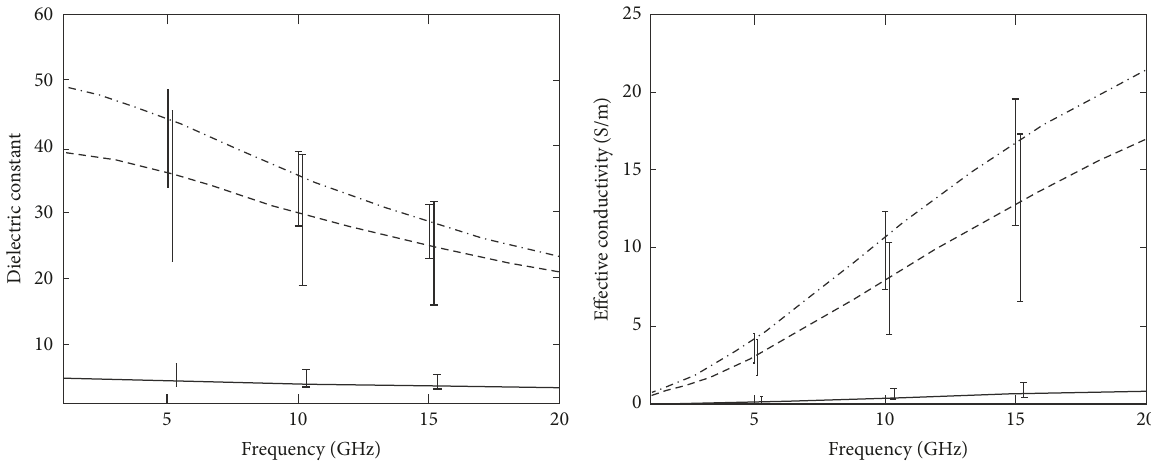
Figure 4: Median dielectric properties of normal breast tissue in three groups categorized by the amount of adipose, from the research team of Wisconsin University and Calgary University. Dash-dot line: group 1 (0–30% adipose), dashed line: group 2 (31–84% adipose), and solid line: group 3 (85–100% adipose) [10]. © Institute of Physics and Engineering in Medicine. Reproduced by permission of IOP Publishing. All rights